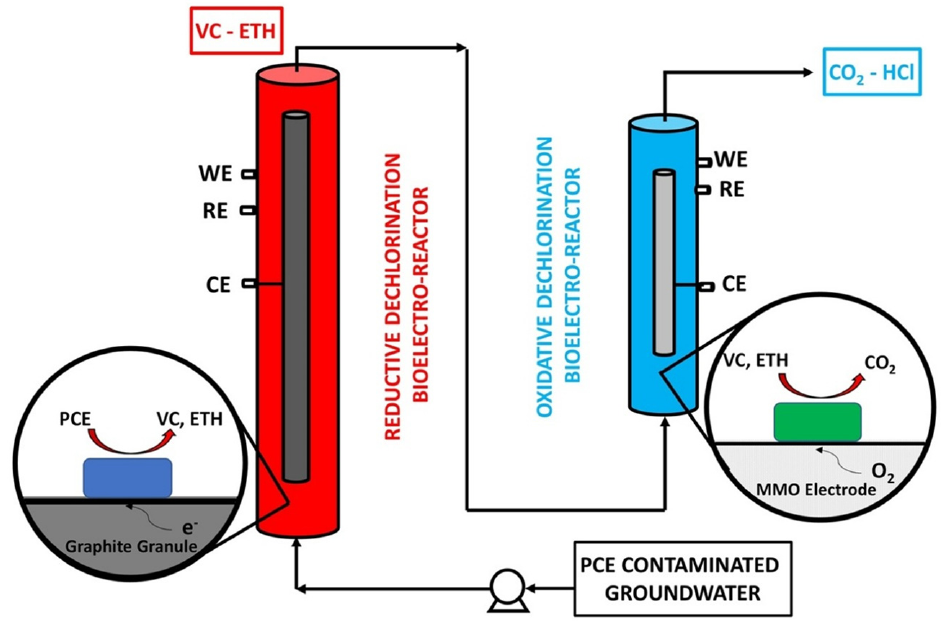
Figure 6. Reductive/oxidative bioelectrochemical reactors combined for biodegradation of PCE and daughter products. Reproduced with the permission of Elsevier, 2020 [87].